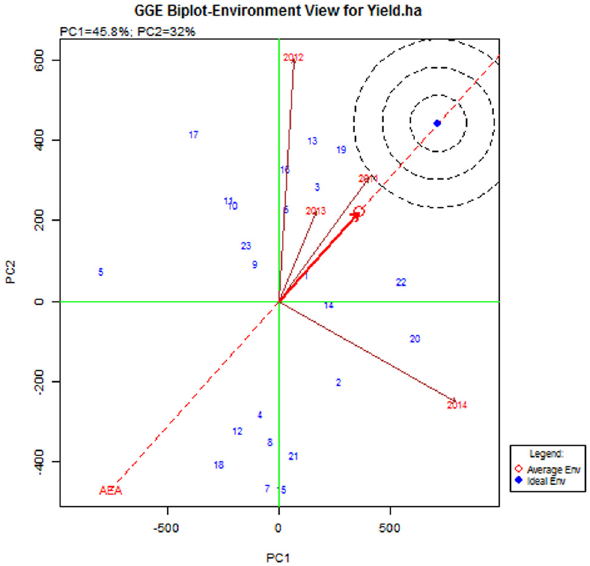
Figure 4: AMMI1 biplot of 23 AYB genotypes seed yield across the four